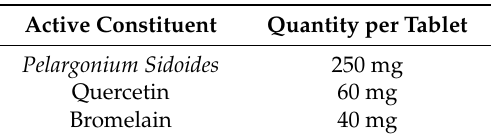
Table 2. Composition of Linctagon Forte ® tablets.